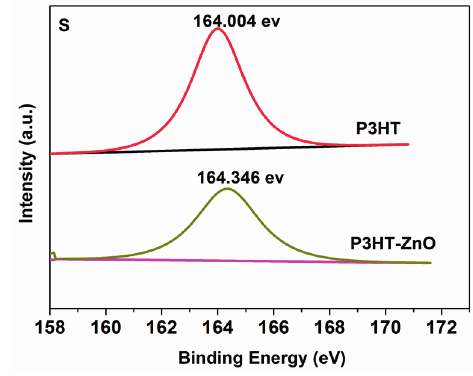
Figure 5. S 2p XPS spectra of P3HT and P3HT-ZnO thin films.